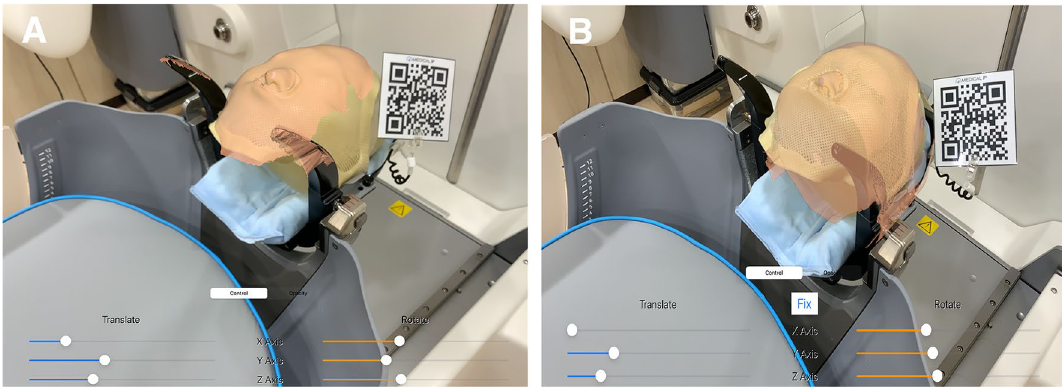
Figure 1. The virtual models and a 3D-printed model overlap correctly using fixed-augmented reality. The virtual model based on 3D-scanning ( A ) and that based on cone-beam computed tomography ( B ) are